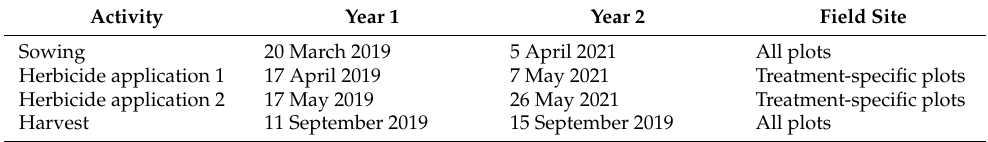
Table 1. Farm management timeline for experimental field plots